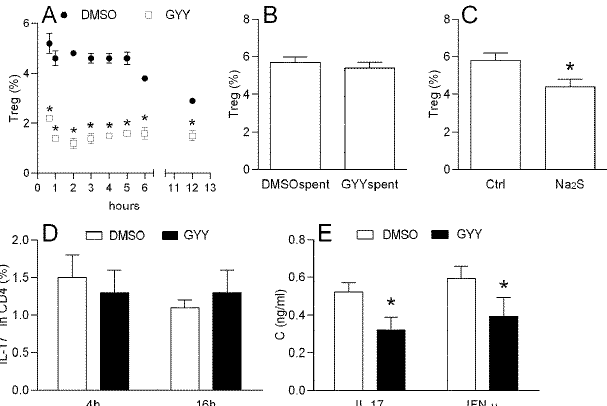
Figure 2. Effects of GYY4137 on the mouse draining lymph node cells (DLNCs). The DLNCs were isolated from the mice immunized with myeline oligodendrocyte glycoprotein (MOG) + complete Freund’s adjuvant (CFA). The percentage of CD4+ CD25+ FoxP3+ cells (regulatory T cells (Treg)), and the proportion of IL17+ among the CD4+ cells were determined by cytofluorimetry. The percentage of Treg among DLNCs was measured after different time points of treatment with 200 μ M GYY4137 (GYY) or DMSO as the solvent control (DMSO) ( A ). The percentage of Treg among the DLNCs was measured after 40 min of treatment with 200 μ M of spent GYY4137 (GYYspent) or spent DMSO as the solvent control (DMSOspent) ( B ), or with Na2S 200 μ M or no treatment (Ctrl) ( C ). Percentage of IL-17+ cells among CD4+ cells was determined among the DLNCs, treated with GYY4137 (GYY) or DMSO as the vehicle (DMSO) for 40 min and subsequently stimulated for 4 h or 16 h ( D ). IL-17 and IFN- γ cytokine concentrations in the supernatants of 24 h cell cultures of MOG re-stimulated DLNCs treated with GYY4137 were determined by ELISA ( E ). The data are presented as the mean + standard deviation (SD) from three ( A – C ) or six ( D , E ) samples. * p < 0.05 refers to DMSO ( A , B , D , E ) or Ctrl ( C ).